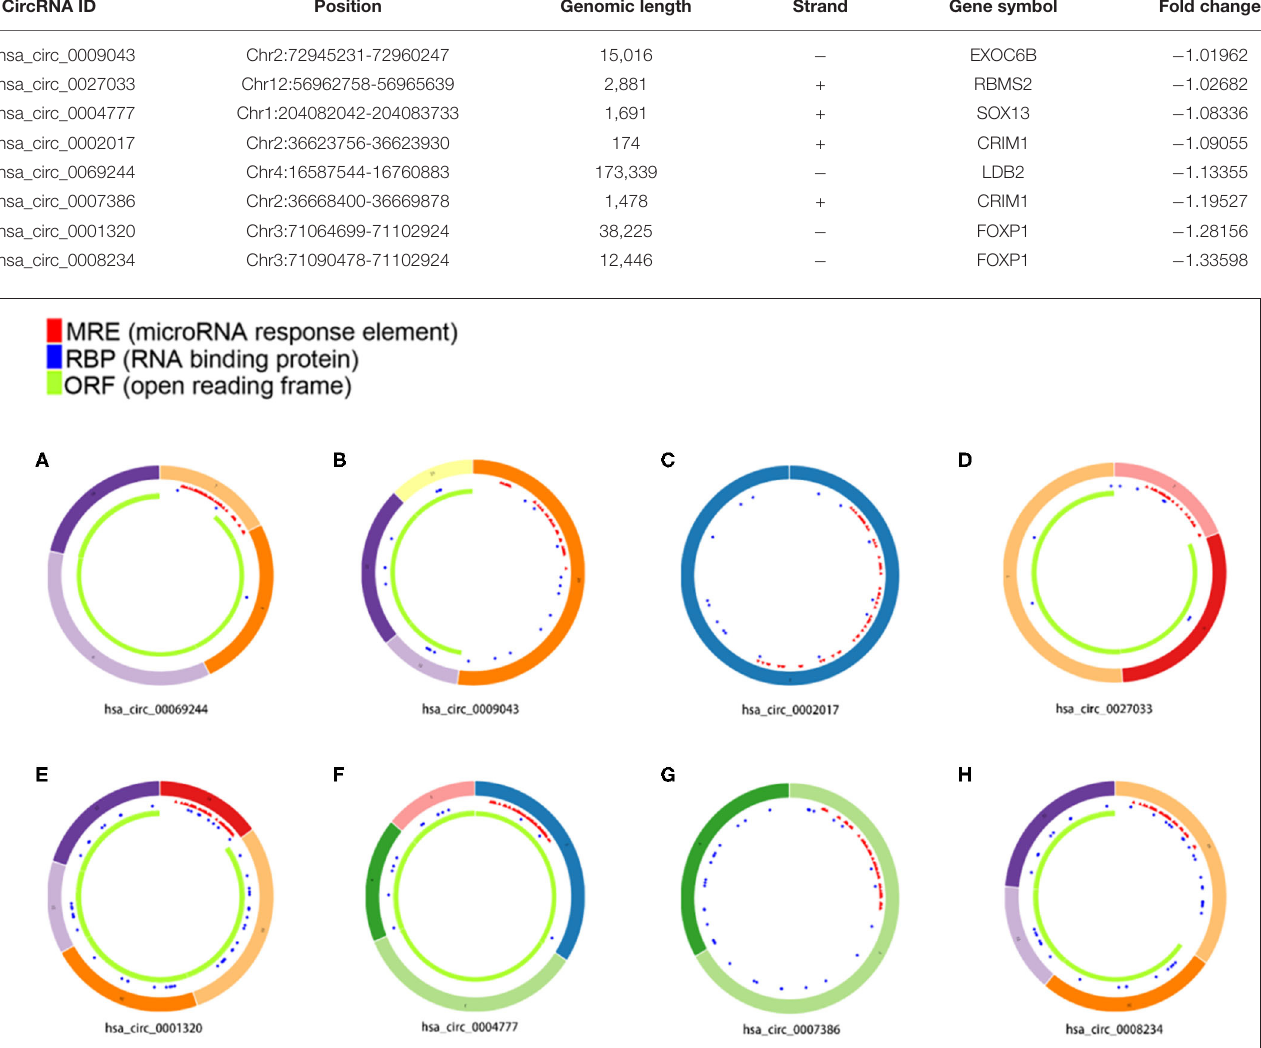
TABLE 1 | Basic characteristics of the eight differentially expressed circRNAs. CircRNA ID Position Genomic length Strand Gene symbol Fold change